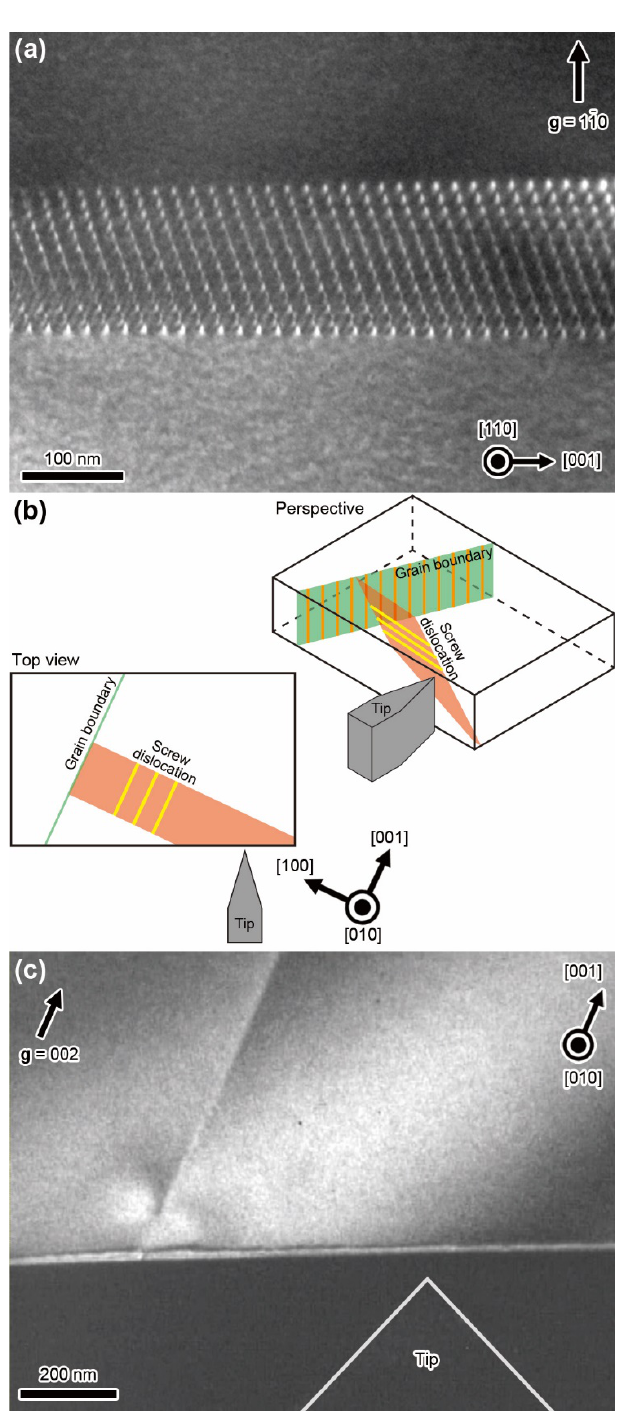
Figure 74. ( a ) A dark-field TEM image of the initial low-angle tilt grain boundary. The specimen was tilted from the edge-on condition to observe the grain boundary plane; ( b ) Schematic illustration of the geometric arrangement of the specimen, the grain boundary, the grain boundary edge dislocations, the indenter tip, and the introduced lattice screw dislocation; ( c ) A dark-field TEM image just before the nanoindentation experiment. The thickness of the specimen is about 150 nm. Adapted with permission from Ref. [276].